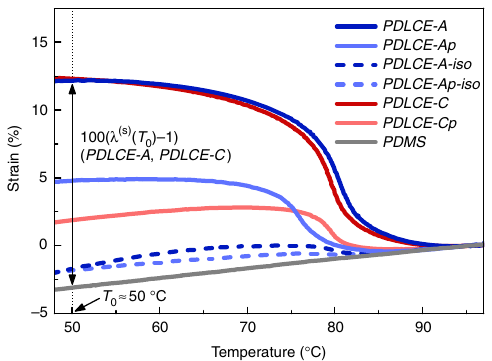
Figure 2 | PDLCE thermomechanical response curves. Experimental l ( T ) ¼ L ( T )/ L ( T ref ) profiles for PDLCE composites listed in Table 2 are shown as percent strain 100( l (cid:3) 1). The reference temperature T ref is 95 (cid:2) C. Specimens with Q 4 0 (solid lines) clearly display expansion on decreasing temperature, with strain anomalies at T l E 80 (cid:2) C reminiscent of pure monodomain LCEs. Low-temperature strains l ( T 0 ) span from at least several per cent for partially aligned samples ( Q o 1) to about 12.5%, equivalently l ¼ 1.125, for the best-performing PDLCE-A and PDLCE-C in which m LCE particles are fully aligned ( Q - 1). On the other hand, isotropic PDLCEs ( Q ¼ 0, dashed lines, suffix ‘ -iso ’) only display a small residual anomaly at T l and contraction on decreasing temperature, with l ( T 0 ) E 0.98.